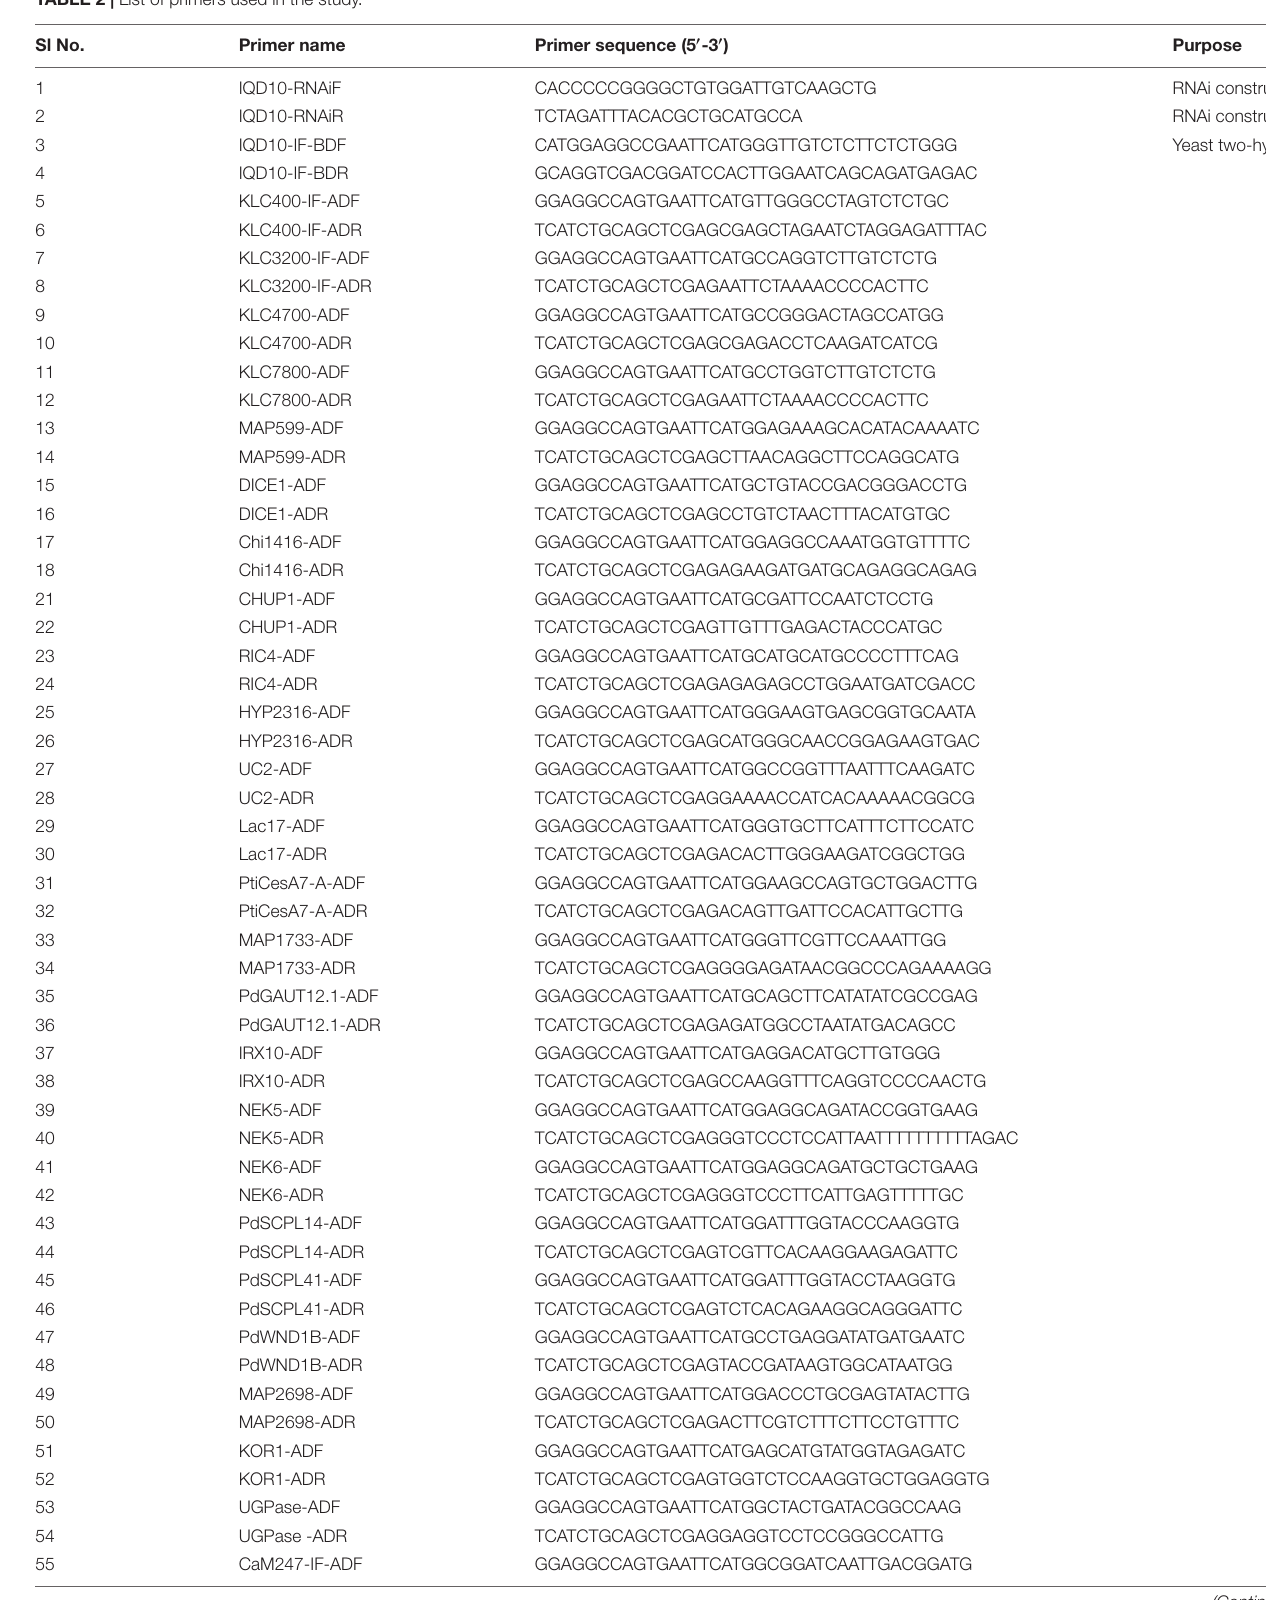
TABLE 2 | List of primers used in the study. Sl